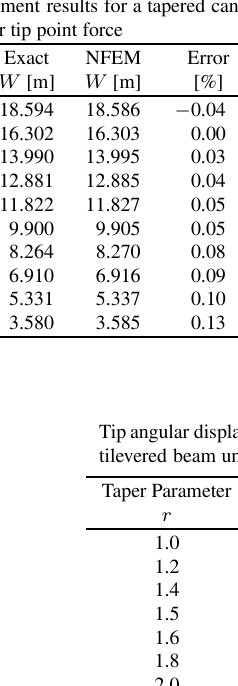
Table 1 Tip vertical displacement results for a tapered